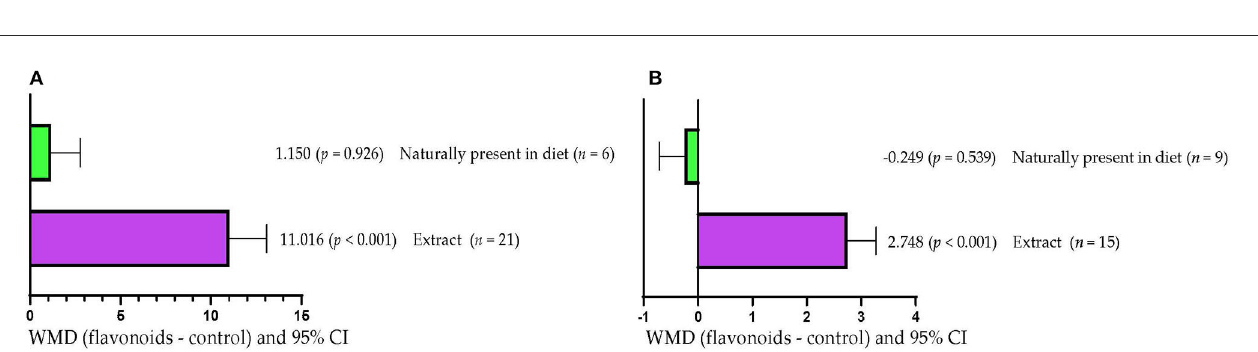
FIGURE5 Subgroup analysis [subgroup method of FLA’s inclusion (extract or naturally present in the diet)] of the effect of flavonoids on the diet of the cattle; = WMDs, weighted mean differences between flavonoid treatments and control. (A) Superoxide dismutase (SOD), U/mL. (B) Milk production,